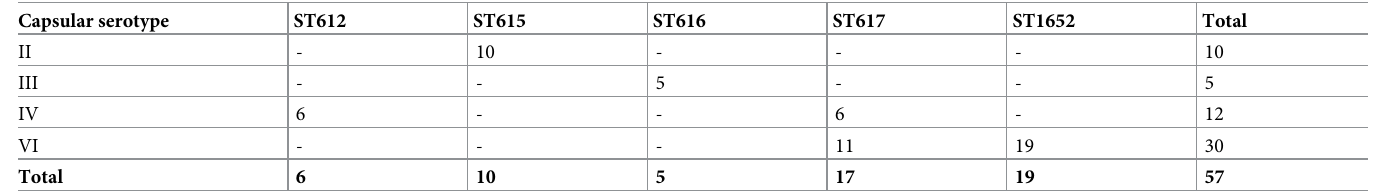
Table 4. Distribution of molecular serotypes and sequence types (STs) among 57 group B Streptococcus isolates collected from milk, nasal, rectal and oral mucosa from lactating camels and their calves in six herds in Laikipia County, Kenya, 2019. Capsular